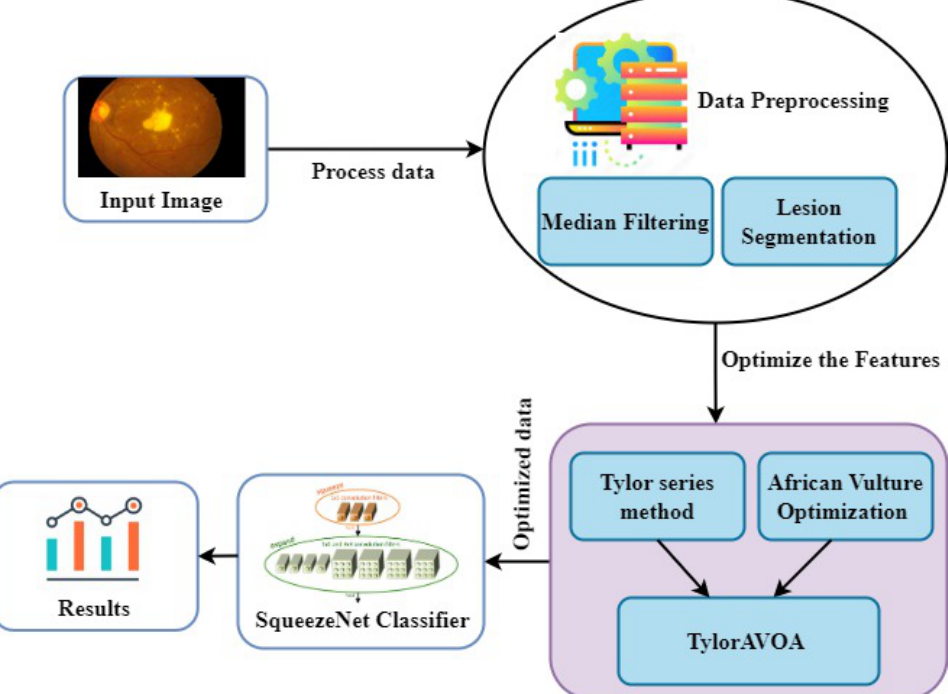
Figure 2. The proposed TaylorAVO-SqueezeNet architecture for DR